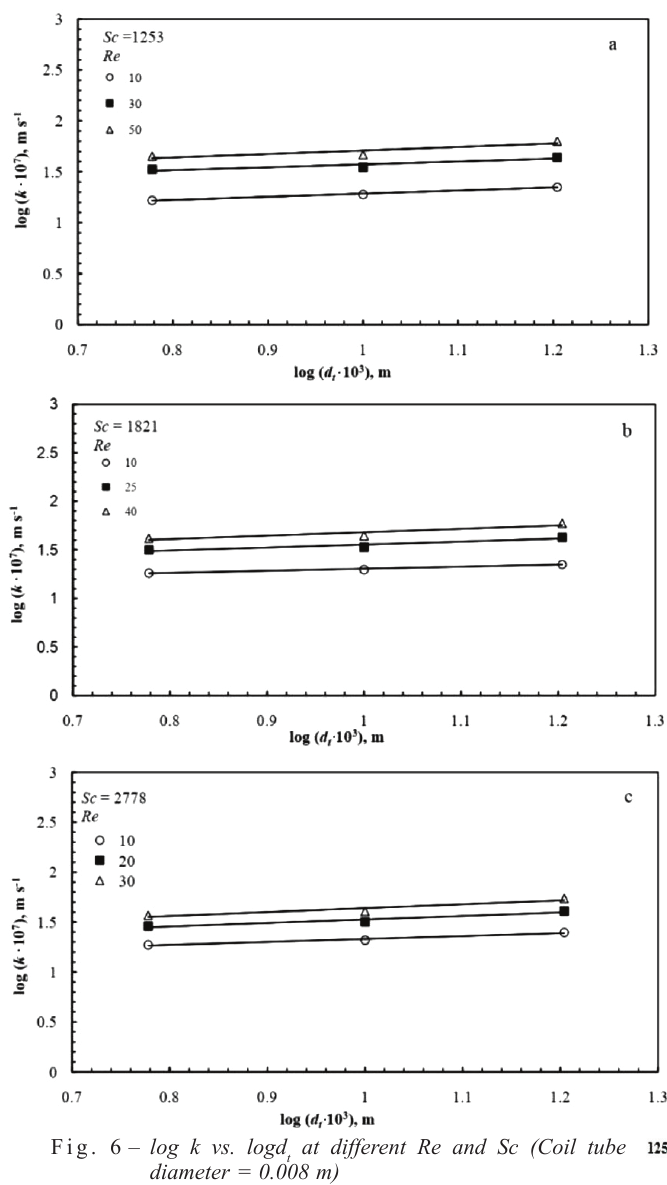
Fig. 6 – log k vs. logd at different Re and Sc (Coil tube t diameter = 0.008 m)